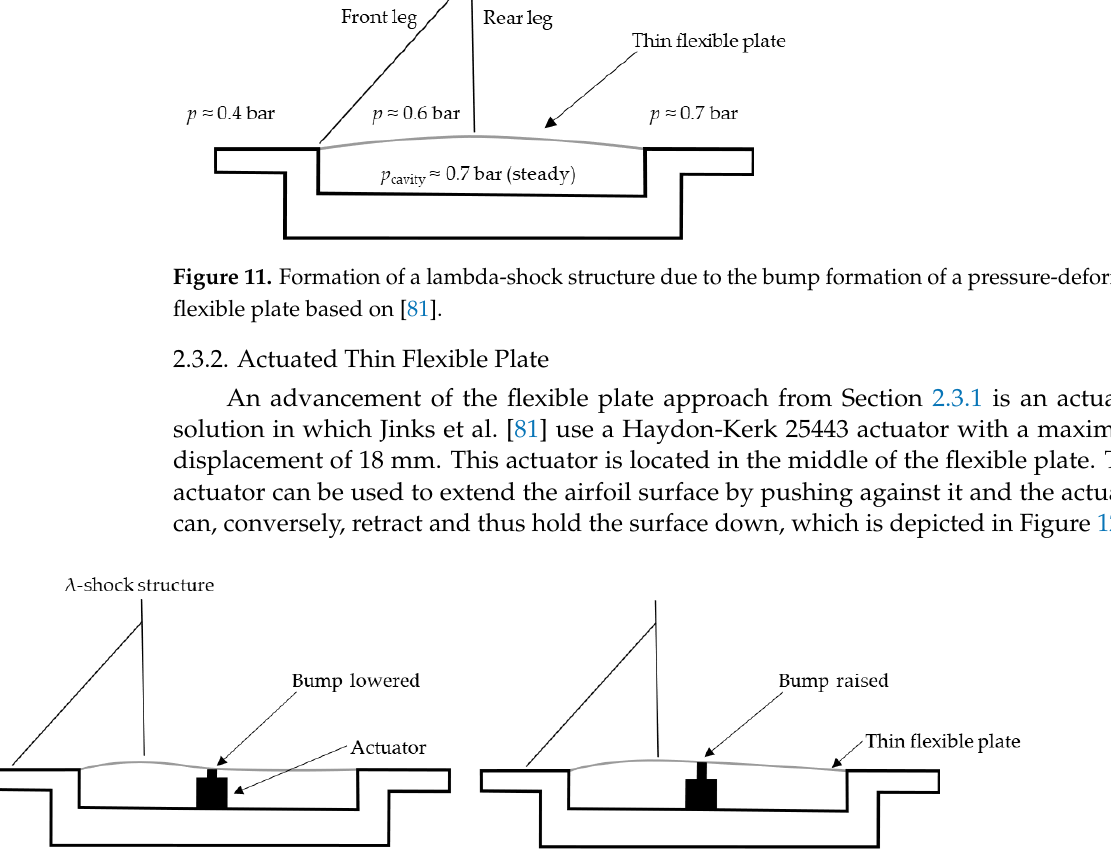
Figure 11. Formation of a lambda-shock structure due to the bump formation of a pressure-de- formed flexible plate based on [81].